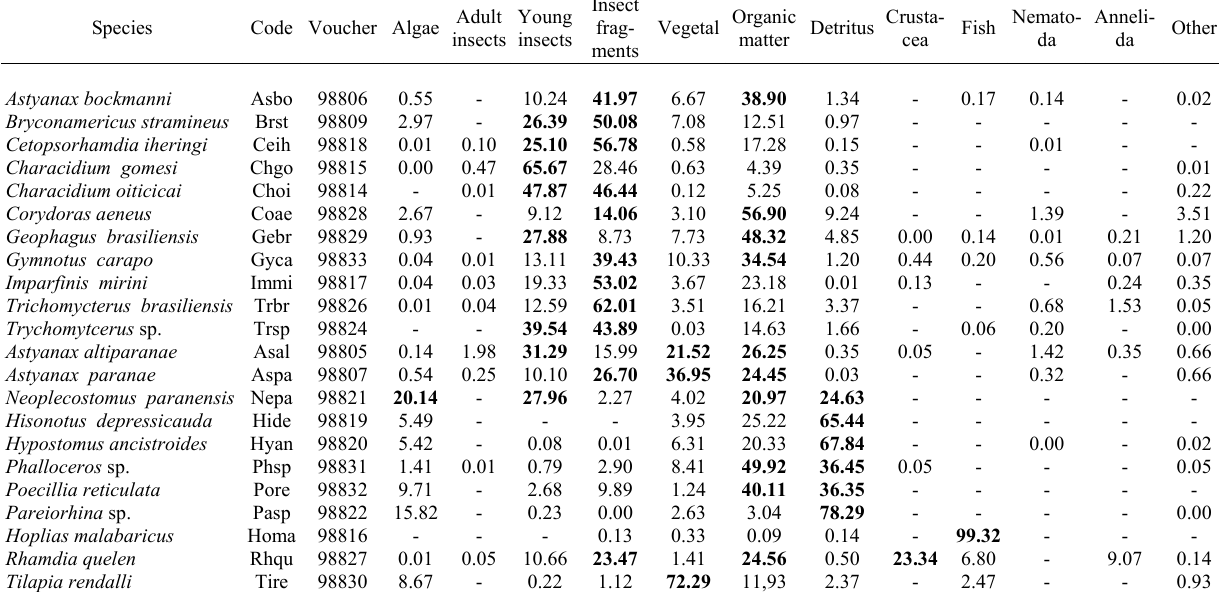
Table 2. Feeding Index (IA ), which combines frequency of occurrence (%) and volume (%) of food items consumed by the i different fish species of Serra do Japi streams (dry and rainy season). Preferential food items are marked in